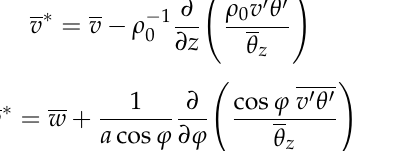
Figure A3. ( a ): Annual average tropical upward mass flux at 70 hPa; ( b ) mean residual vertical ve- locities 𝑤̅ ∗ at 70 hPa from ERA5 for 2005 – 2020.